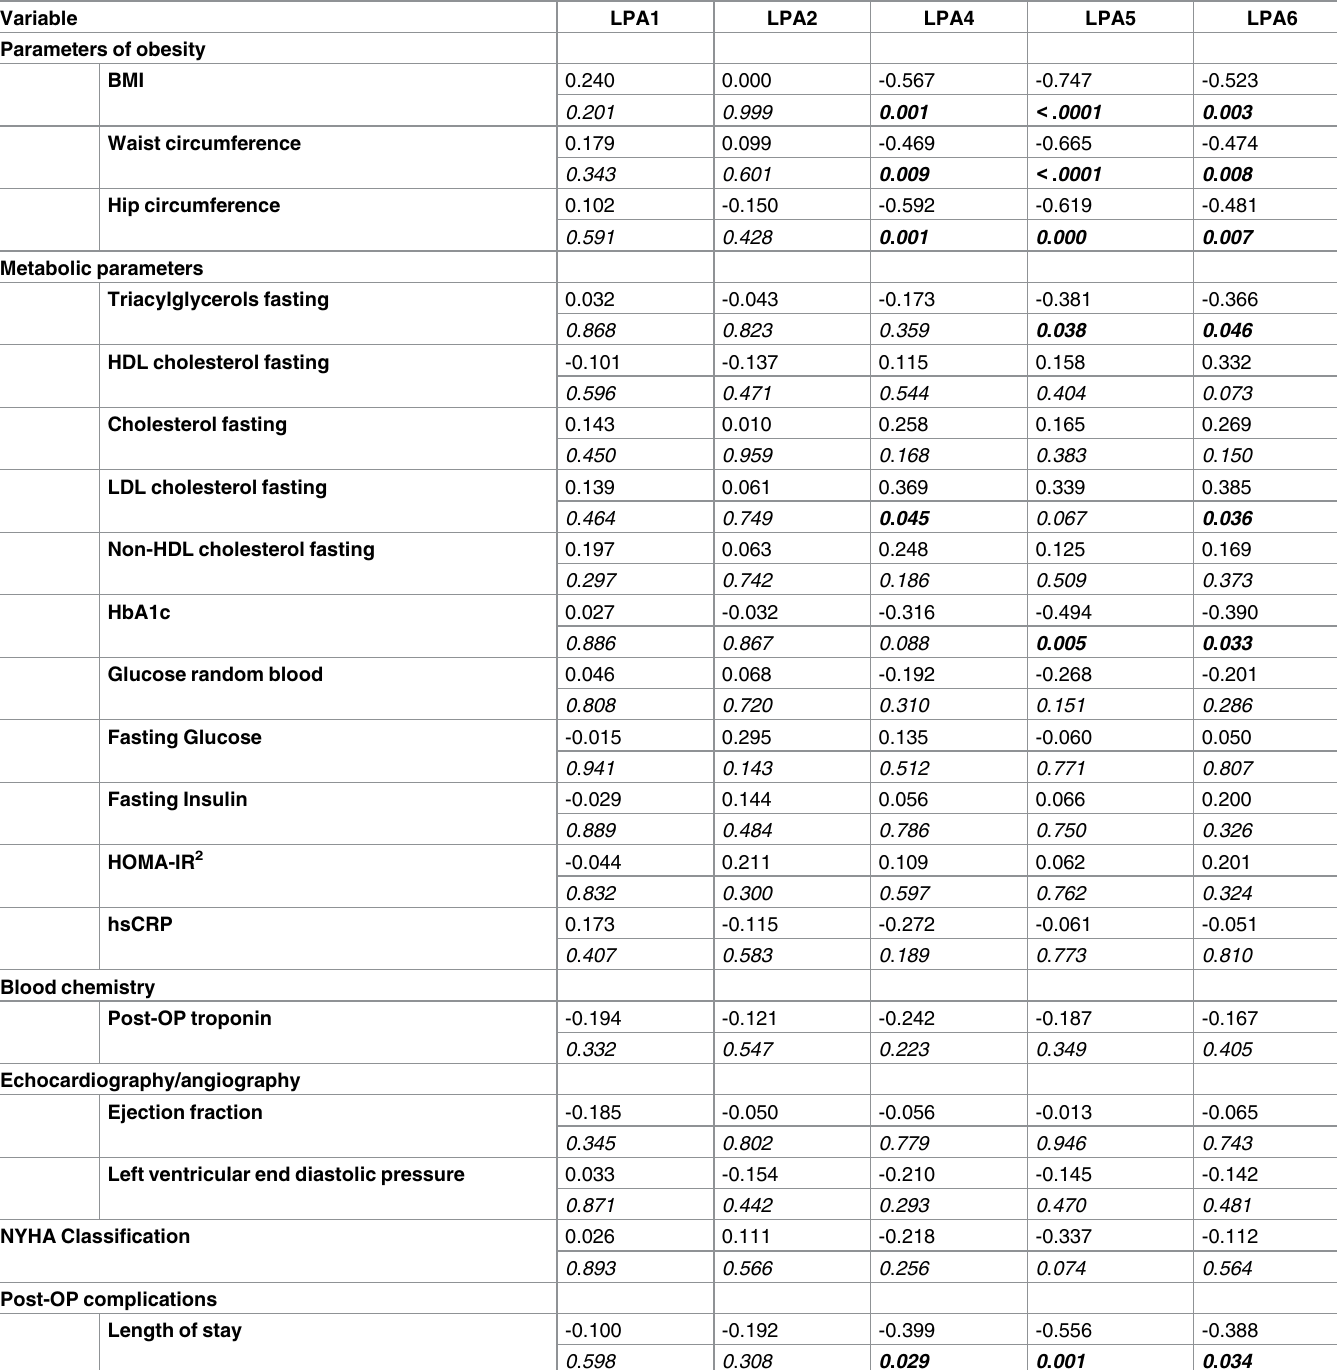
Table 7. Unadjusted Pearson’s correlations of LPA receptors in subcutaneous adipose tissue from cardiac surgery